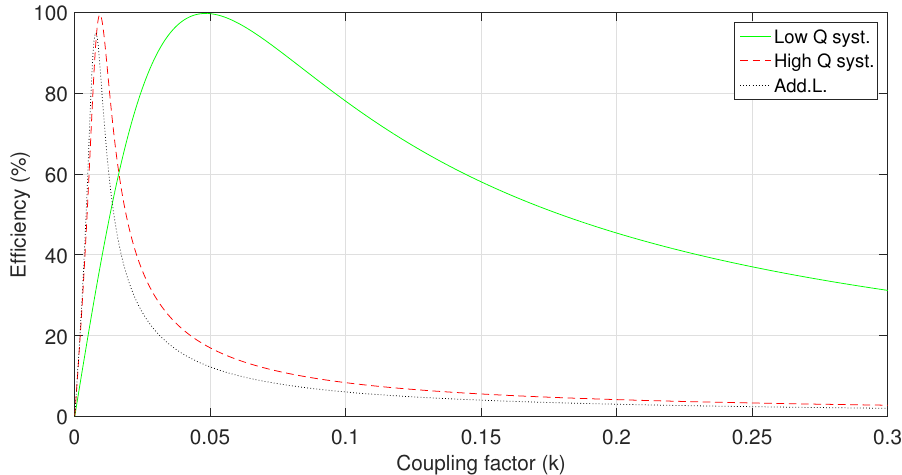
Figure 8. Comparison of the maximum distance between the T X and R X loops of the system with low Q design, with and without additional inductors and a system with high Q coil